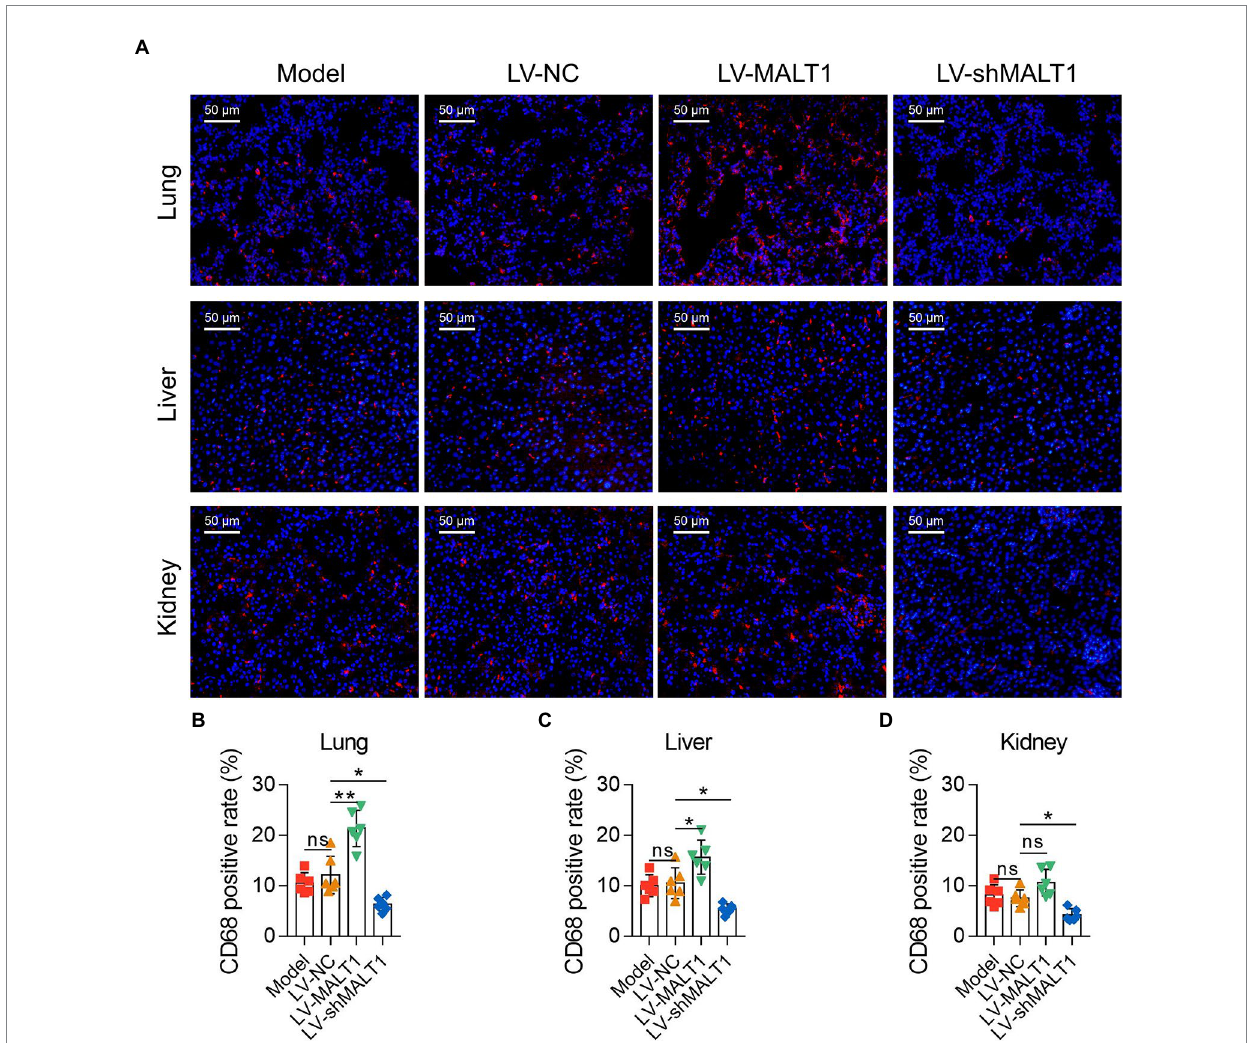
FIGURE 4 Effect of MALT1 on macrophage infiltration in LPS-induced septic mouse model. IF staining of macrophages in lung, liver, and kidney tissues among the Model, LV-NC, LV-MALT1, and LV-shMALT1 groups (A) . Comparison of the CD68-positive rate in the lung (B) , liver (C) , and kidney (D) among the Model, LV-NC, LV-MALT1, and LV-shMALT1 groups. n = 6 in each group. One-way ANOVA plus Tukey’s post hoc test was applied. Ns, not significant; * p < 0.05; ** p <